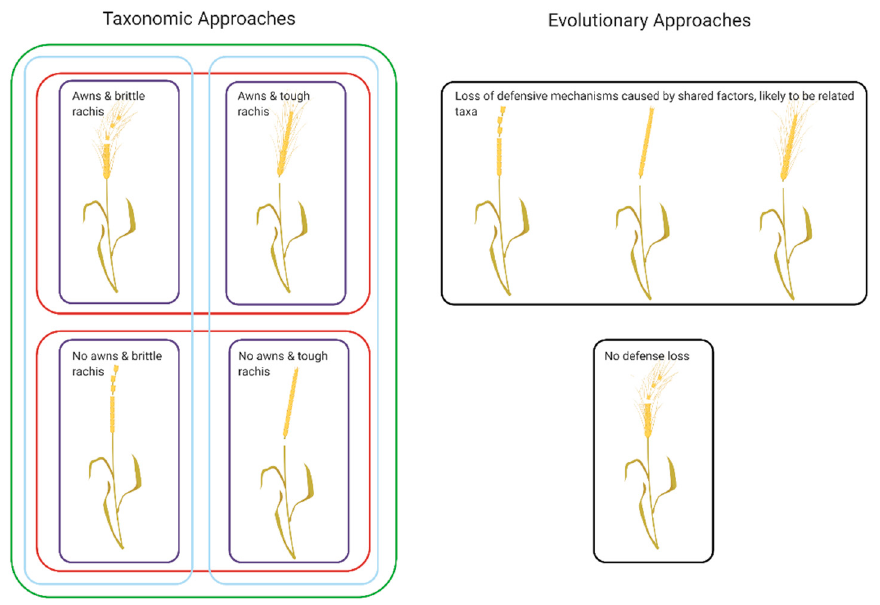
Figure 1. Schematic comparison of taxonomic and evolutionary approaches to categorizing taxa using a hypothetical cereal. Under the taxonomic scheme the different ‘features’, in this case morphological, are used to lump or split the taxa into categories. This can be as many or as few as the accessioner deems appropriate. The multiple boxes drawn show how this could be achieved—it could be highly split into four groups, or into two based on whether the awn presence or rachis toughness, or into a single group based on this being a taxa distinct from others that look different from it over all. On the other hand, the evolutionary approach, using the same features, again morphological, is looking to see relatedness between the taxa, and suggests that the loss of defensive mechanism is an indicator of relatedness, and the plant with no loss of defenses should be placed in a group on its own. The motivations for ‘creating’ species/categories can therefore have profound effects on how we divide and identify the objects of our study, and create models for how they come into being. [Created with BioRender.com, under a CC BY license, with permission from Biorender, original copyright 2020..].